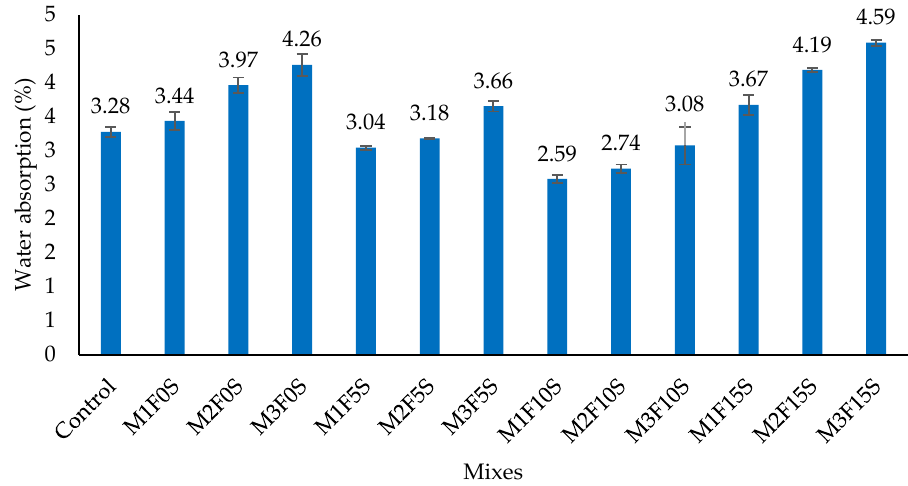
Figure 11. Water absorption results.